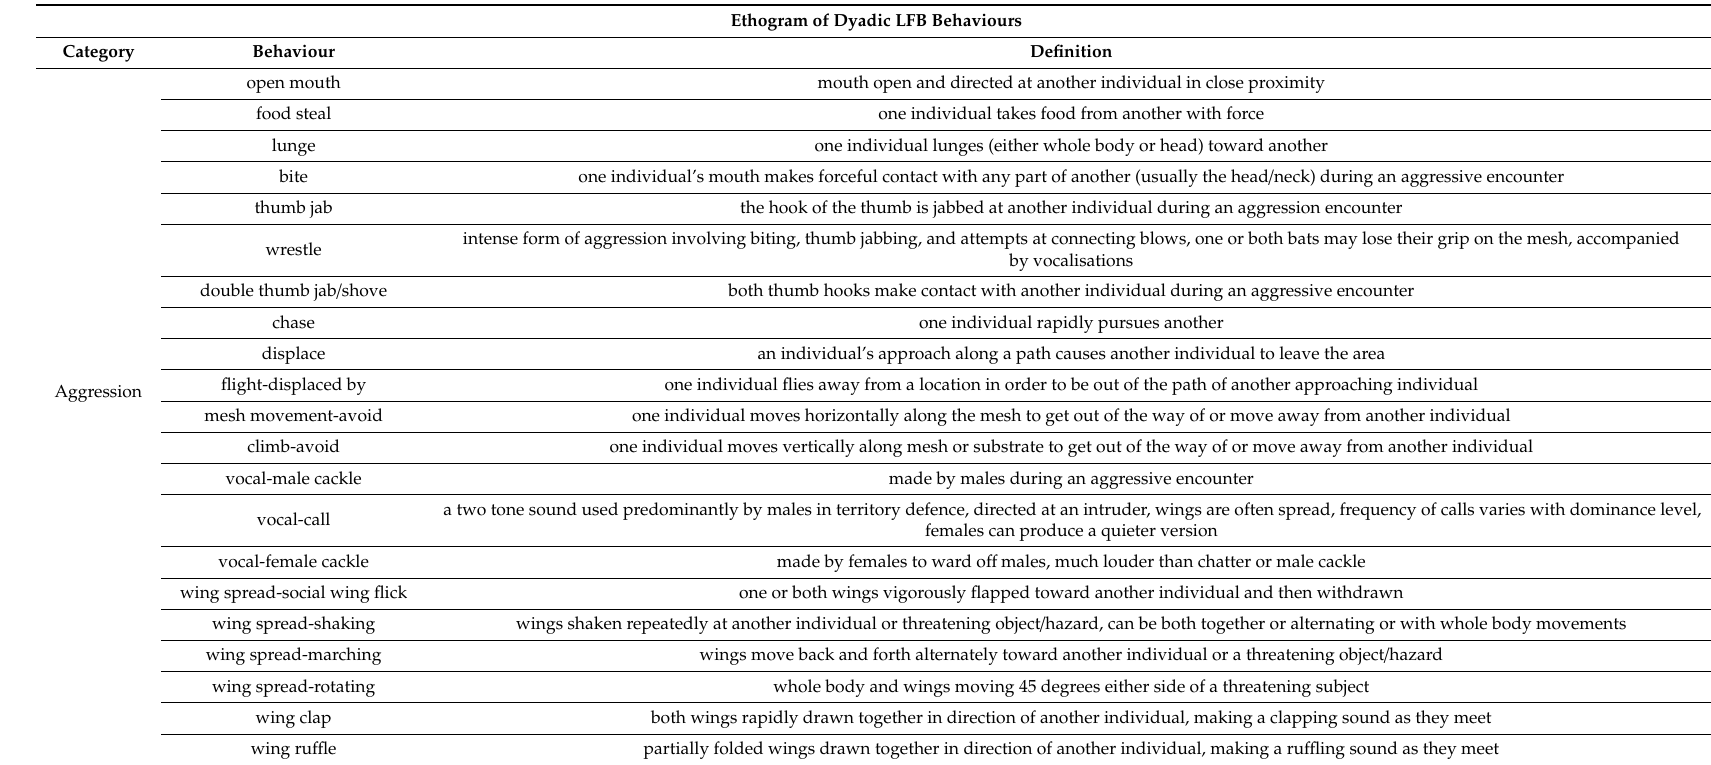
Table A1. Ethogram of aggressive and a ffi liative Livingstone’s fruit bat behaviours used for data collection, as described by Courts